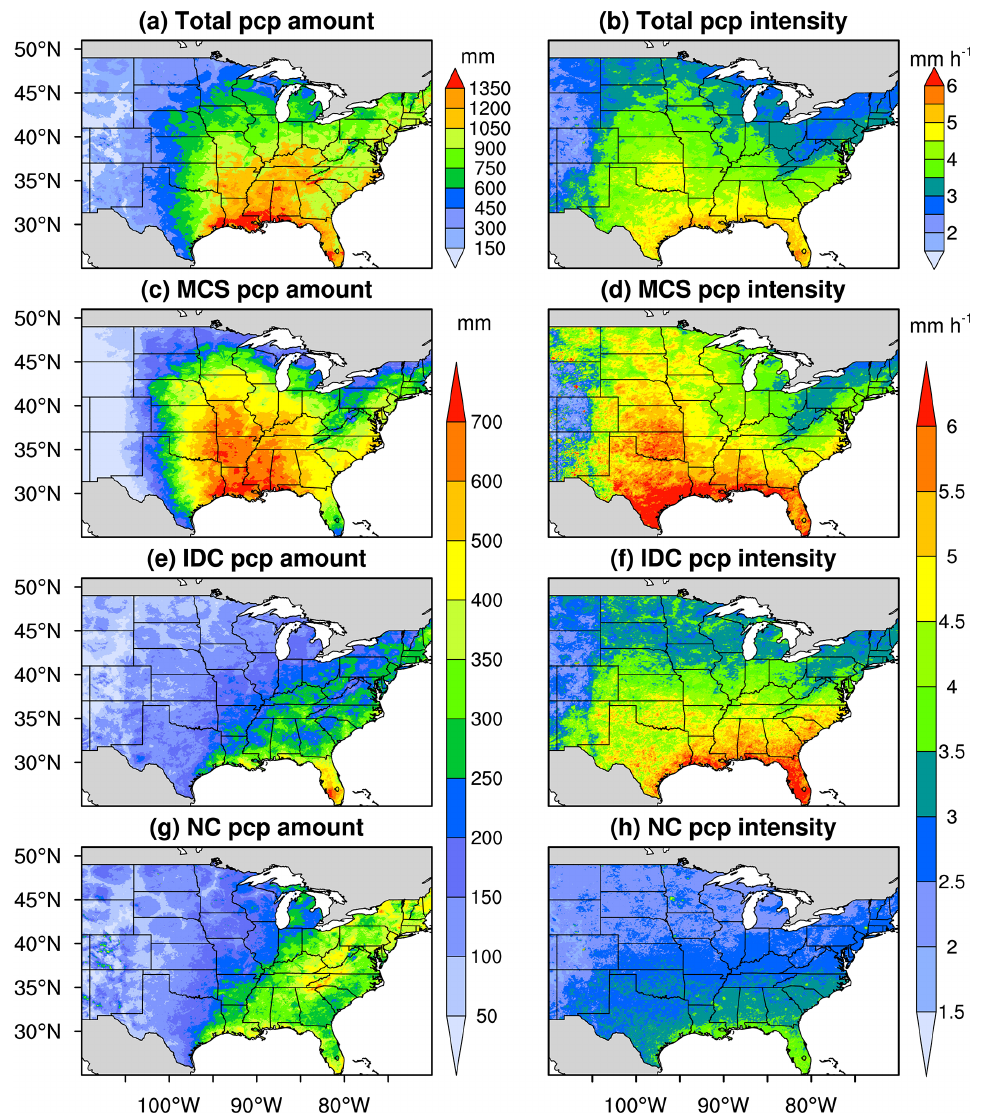
Figure 5. Distributions of annual mean precipitation amounts (a, c, e, g) and intensities (b, d, f, h) for different types of precipitation for 2004–2017. Panels (a) and (b) are for total precipitation, (c) and (d) are for MCS precipitation, (e) and (f) are for IDC precipitation, and (g) and (h) are for NC precipitation. We only include hourly data with precipitation > 1mmh − 1 in the